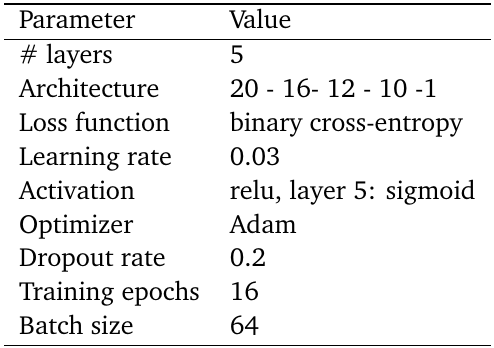
Table 2: Hyperparameters of the neural network